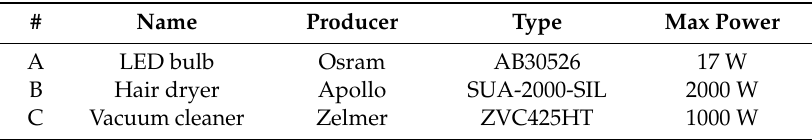
Figure 4. The sequence of switching on and off tested appliances.